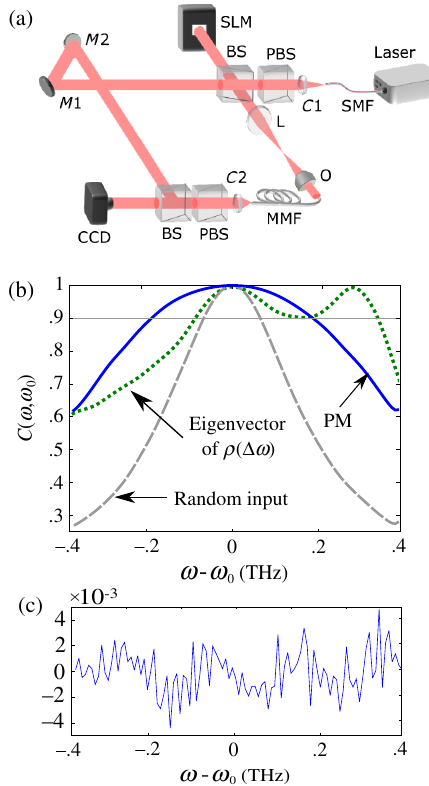
FIG. 1. (a) Schematics of the experimental setup. The output from a frequency-tunable laser, injected by a SMF, is collimated by a lens ( C 1 ) and linearly polarized by a polarization beam splitter (PBS) before being split by a beam splitter (BS) into two paths. (i) The signal is spatially modulated by the SLM and then imaged onto the fiber facet of the MMF by a lens ( L ) and a micro- objective ( O ). (ii) The reference arm matches the signal arm ’ s path length by a pair of mirrors M 1 and M 2 . The output from the MMF is collimated ( C 2 ) and polarized (PBS) before combining with the reference signal at the BS with a relative angle. The interference fringes are recorded by a CCD camera. (b) Exper- imentally measured autocorrelation function C ð ω ; ω 0 Þ for the most stable PM (blue solid line). For comparison, we also show the measured average correlation of 20 random inputs (gray dashed line) with a narrower bandwidth. A super-PM eigenvector of ρ ð Δ ω Þ with Δ ω ¼ 0 . 28 THz is evaluated using the measured transmission matrix and its correlation function (green dotted curve). The horizontal solid gray line indicates the threshold value C ð ω ; ω 0 Þ ¼ 0 . 90 that sets the correlation width. In panel (c), we plot the fluctuations of the measured correlation function of the PM shown in panel